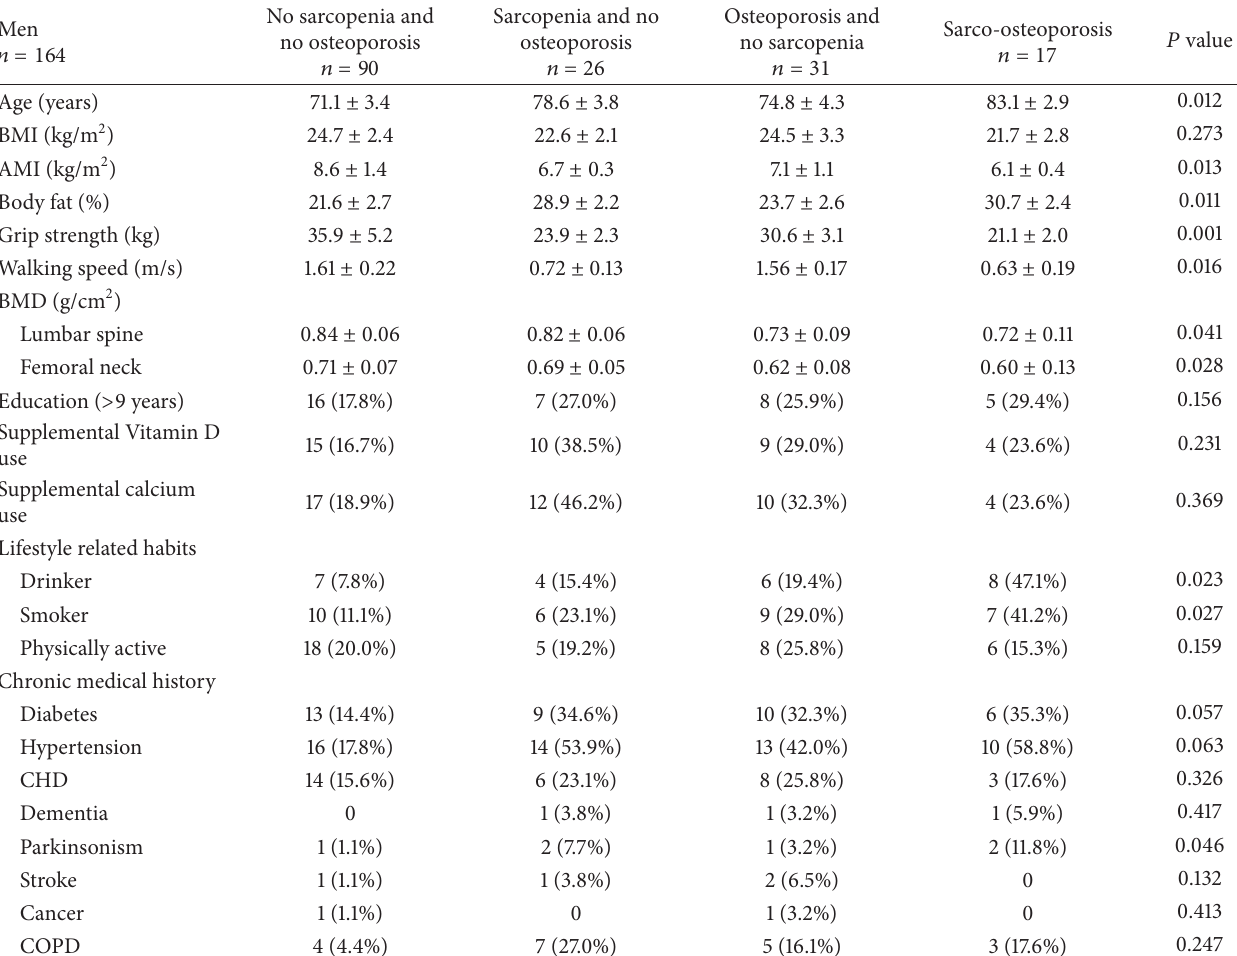
Table 2: Subject characteristics of men by musculoskeletal diseases